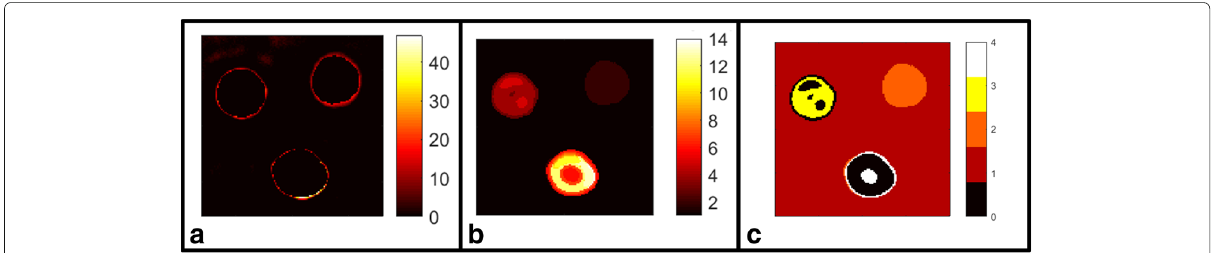
Fig. 6 Each step of the results. a Background noise suppressed by thresholding (for each pixel, the maximum noise amplitudes over all of the wavelengths is shown). b Output of the spatio-spectral mean-shift algorithm. c Two-dimensional map obtained, keeping only the P largest labeled areas. Unlabeled pixels are in black (label sets to zero)